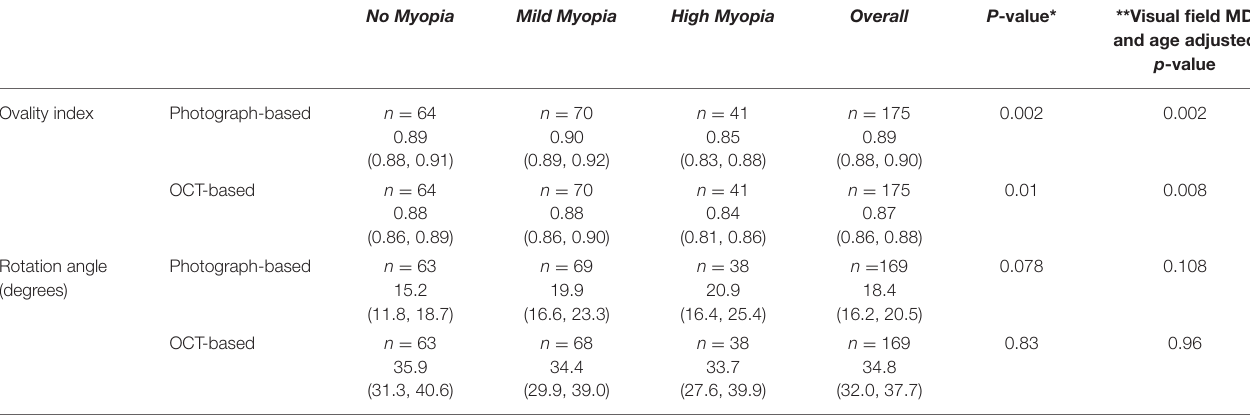
TABLE 2 | Ovality Index (closer to 0 = more oval, closer to 1 = more circular) and Rotation Angle by Myopia